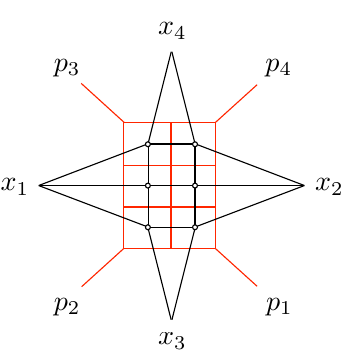
Figure 2 . A transformation maps the space-time integral into a momentum space amplitude, shown in red lines, with external massive momenta p 1 = x 23 , p 2 = x 31 , p 3 = x 14 and p 4 = x 42 , and with massless internal lines. The latter amplitude is subject to important analyticity requirements such as the Steinmann